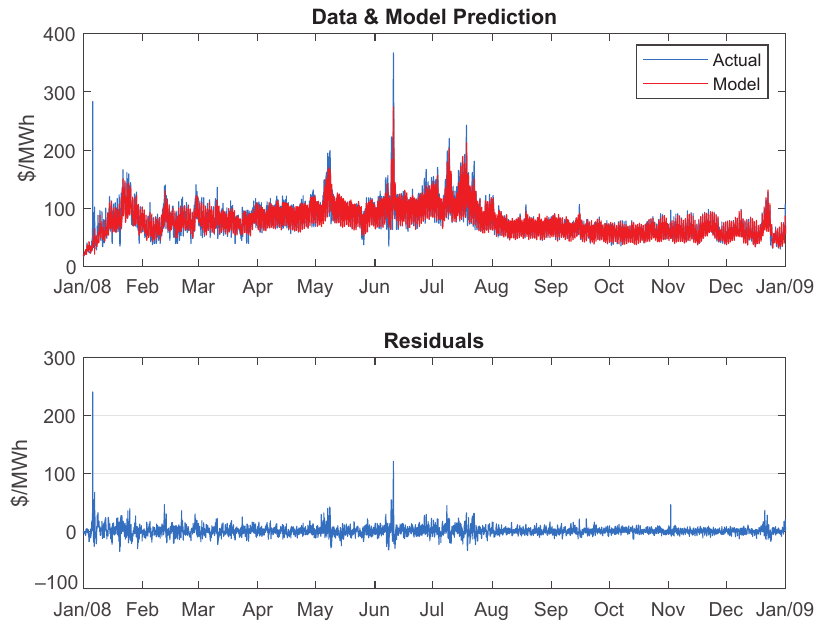
Figure 9. Forecast results of electricity prices. Table 5. Comparison of proposed ANN results with